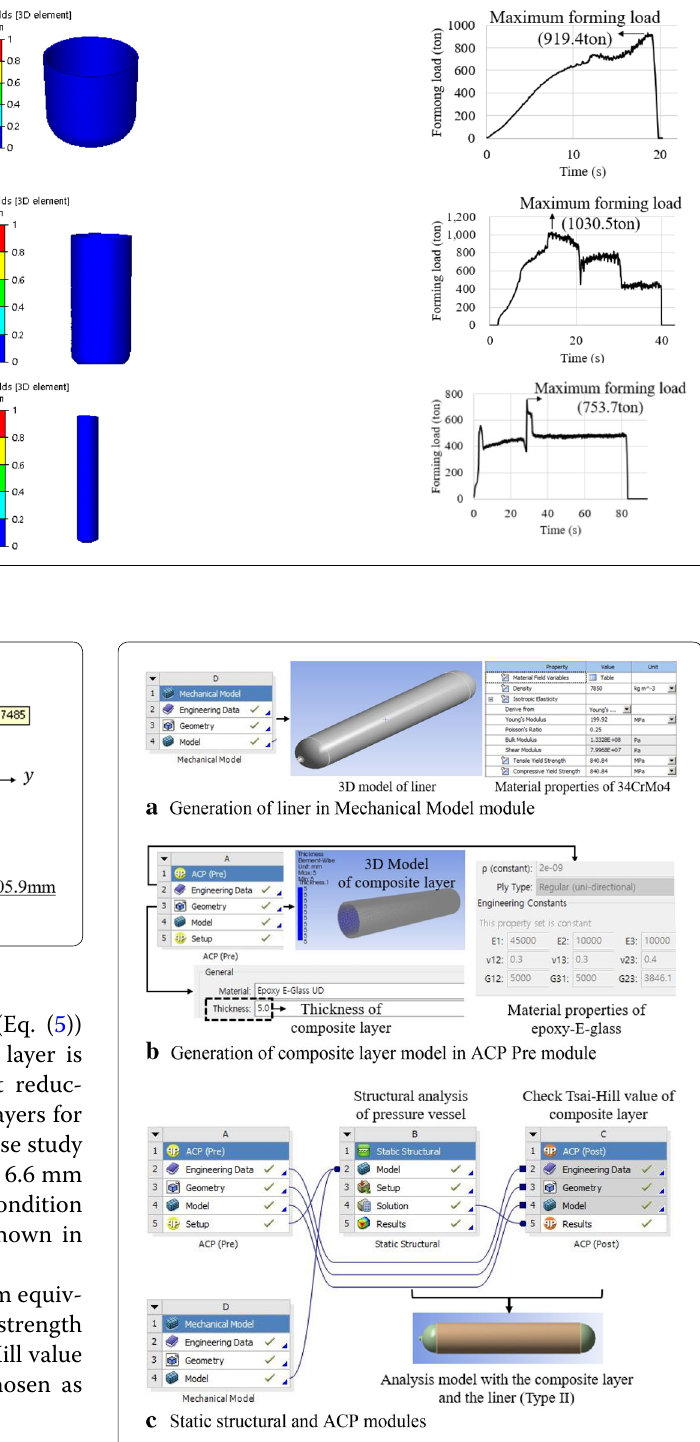
Figure 17 Static structural analysis of the pressure vessel (Type II) in the each